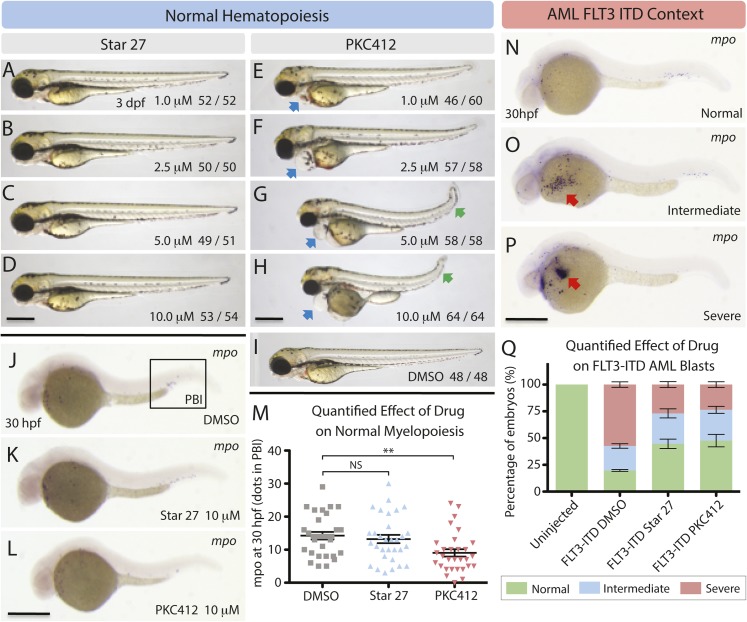
Effects of Star 27 on D. rario (zebrafish) WT morphology and myelopoiesis, and FLT3-ITD AML context.Effect of Star 27 on zebrafish normal myelopoiesis and the FLT3/ITD-induced myeloid cells expansion. (A–D) The effect of Star 27 on zebrafish embryonic development at 3 dpf, showing no noticeable morphological defects up to 10 μM. (E–I) The effect of PKC412 on zebrafish embryonic development at 3 dpf, showing substantial pericardial defects beginning at 500 nM (data not shown), and tail curvature and length defects beginning at 1 μM and 2.5 μM, respectively vs. vehicle. (J, K, M) The effect of 10 μM Star 27 treatment on mpo+ myeloid cells development in the posterior blood island (PBI) at 30 hpf, showing no statistically significant change. (J, L, M) The effect of 10 μM PKC412 treatment on mpo+ myeloid cells development in the PBI at 30 hpf, showing a statistically significant granulogenesis/myelosuppression. (N–P) Three categories of mpo transcription (N, normal; O, intermediate; P, severe) were defined based on the WISH results (three experiments). (Q) The rescue effect of 10 μM Star 27 treatment on FLT3/ITD-induced mpo+ myeloid cells expansion at 30 hpf, showing rescue of normal phenotype approaching that seen for AC220 (He et al., 2014). Scale bar equals 500 μm. Blue arrows indicate the pericardial edema, green arrows indicate tail shortening and curving, and red arrows indicate the FLT3-ITD AML mpo+ myeloid cells expansion. PKC412 treatment on FLT3/ITD-induced mpo+ myeloid cells expansion at 30 hpf, showing an efficaciousness similar to Star 27, consistent with Figures 1–3. For all experiments: Zebrafish embryos were collected and kept in standard E3 medium at 28°C. Different concentrations of either drug were added to the E3 medium from 6 hr post fertilization (hpf) to 3 days post fertilization (dpf). Embryos treated with DMSO or 10 μM drug from 6 to 30 hpf were collected for mpo whole mount in situ hybridization (WISH) analysis. 80 ng plasmid DNA containing FLT3/ITD sequence was microinjected into one-cell stage embryos, and the uninjected embryos were used as control. FLT3/ITD-injected embryos were treated with DMSO or 10 μM drug from 6 to 30 hpf. Embryos were collected at 30 hpf for mpo WISH analysis. **p <0.01.